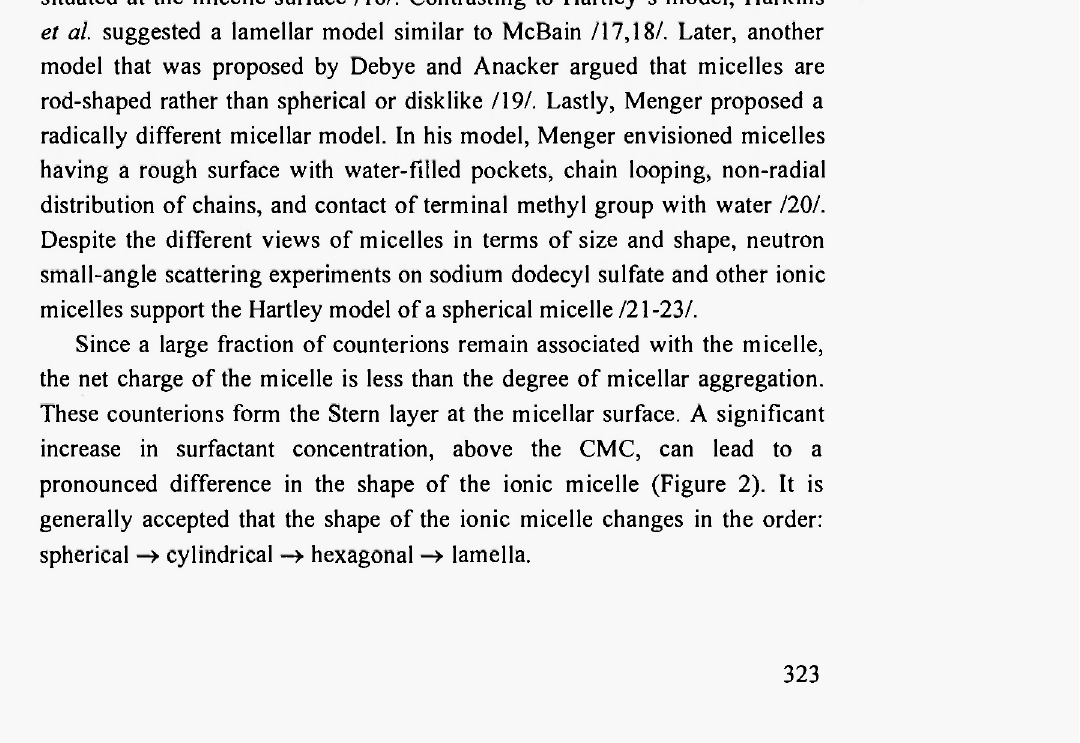
Fig. 1: Different proposed structures of the micelle. From /31 /, with